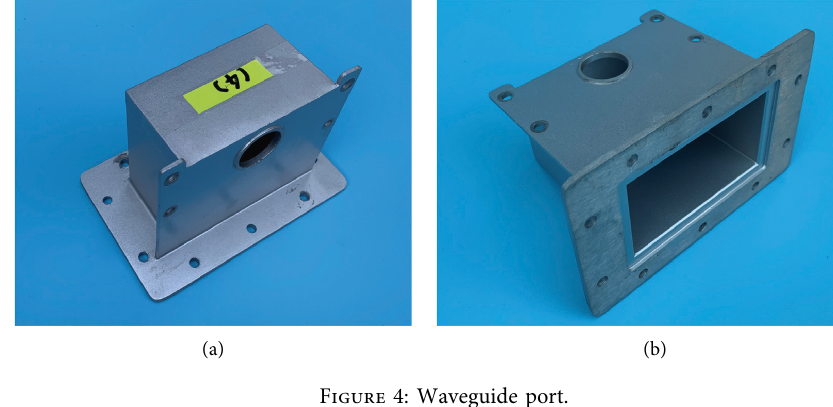
Figure 4: Waveguide port.